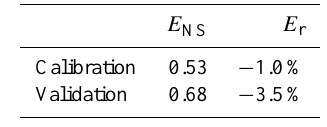
Table 2. Performance of the SWAT model in the calibration (1960– 1979) and validation (1980–2000) periods.